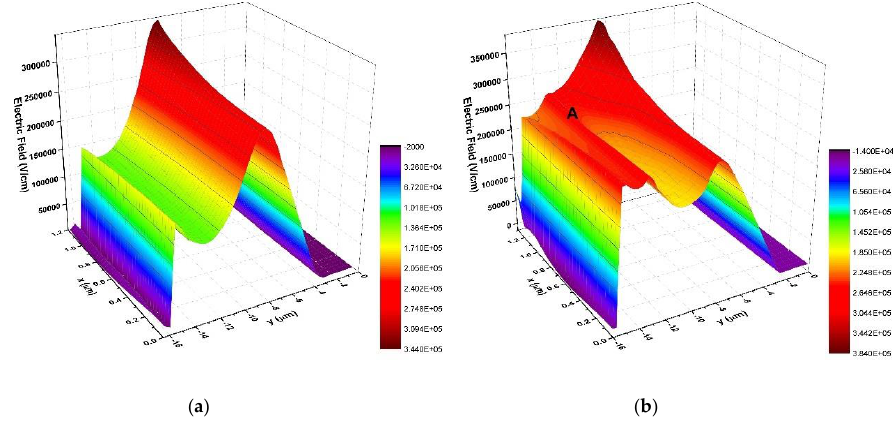
Figure 3. The three dimensions view of electric field distributions for the ( a ) SGRSO and ( b ) HDSGRSO UMOSFET with the same n-drift region doping concentration ( N D and N 2 ) 5 × 10 15 / cm − 3.